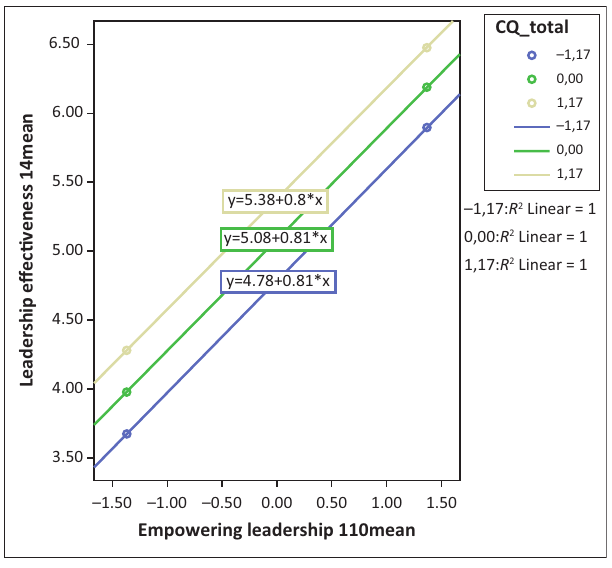
FIGURE 1: Leader cultural intelligence (aggregate) moderation on the relationship between empowering leadership and leadership effectiveness.